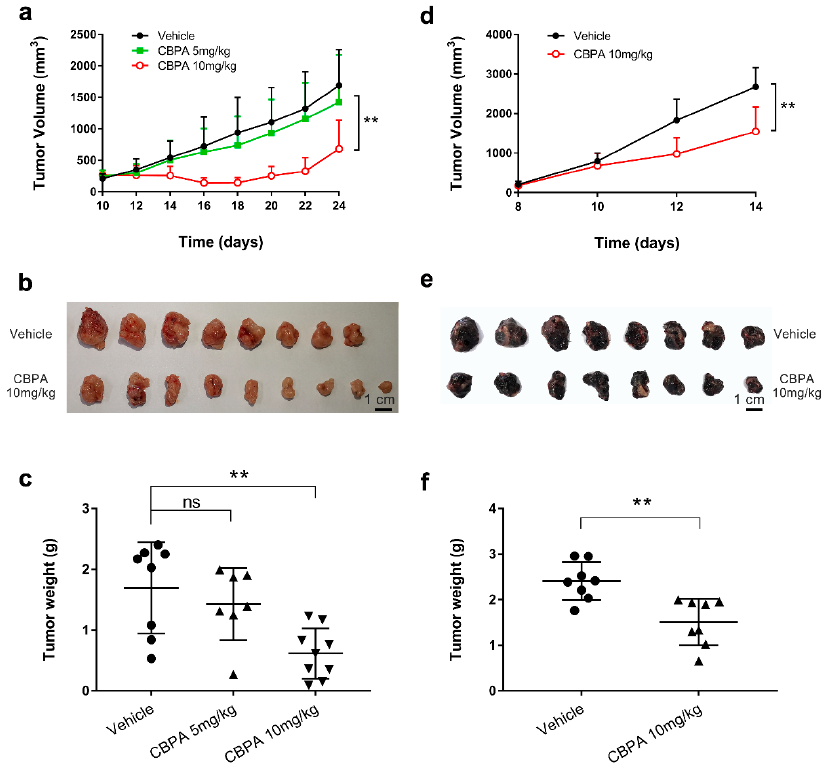
Figure 6. In vivo efficacy study of the CBPA in the tumor-bearing C57BL/6 mice models. ( a ) MC38 tumor volume changes during treatment with vehicle (n = 8), 5 mg/kg CBPA (n = 7), and 10 mg/kg CBPA (n = 9), respectively. ( b , c ) The images and weights of excised MC38 tumors in each group. ( d ) B16F10 tumor volume changes during treatment with vehicle (n = 8) and 10 mg/kg CBPA (n = 8), respectively. ( e , f ) The images and weights of excised B16F10 tumors in each group. All quantitative data are represented as means ± SEM, ** p < 0.01, unpaired t -test.